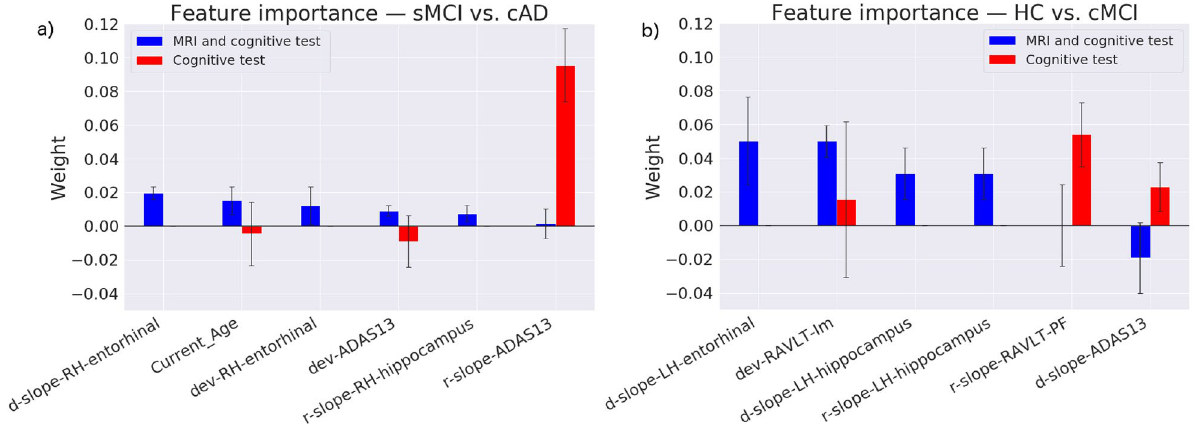
Figure 7. Feature weights when classifying sMCI vs. cAD ( a ) and HC vs. cMCI ( b ), based on cognitive features (in red) and the combination of MRI and cognitive features (in blue). For convenience, the plots only show a selection of the most important features after adding the MRI features to the analyses. Weights near zero and features for which the permutation importance had standard deviations greater than the estimated mean weight are not plotted. The most important features, when predicting from only the cognitive tests, were kept in the plot to illustrate the main changes observed after adding the MRI features.